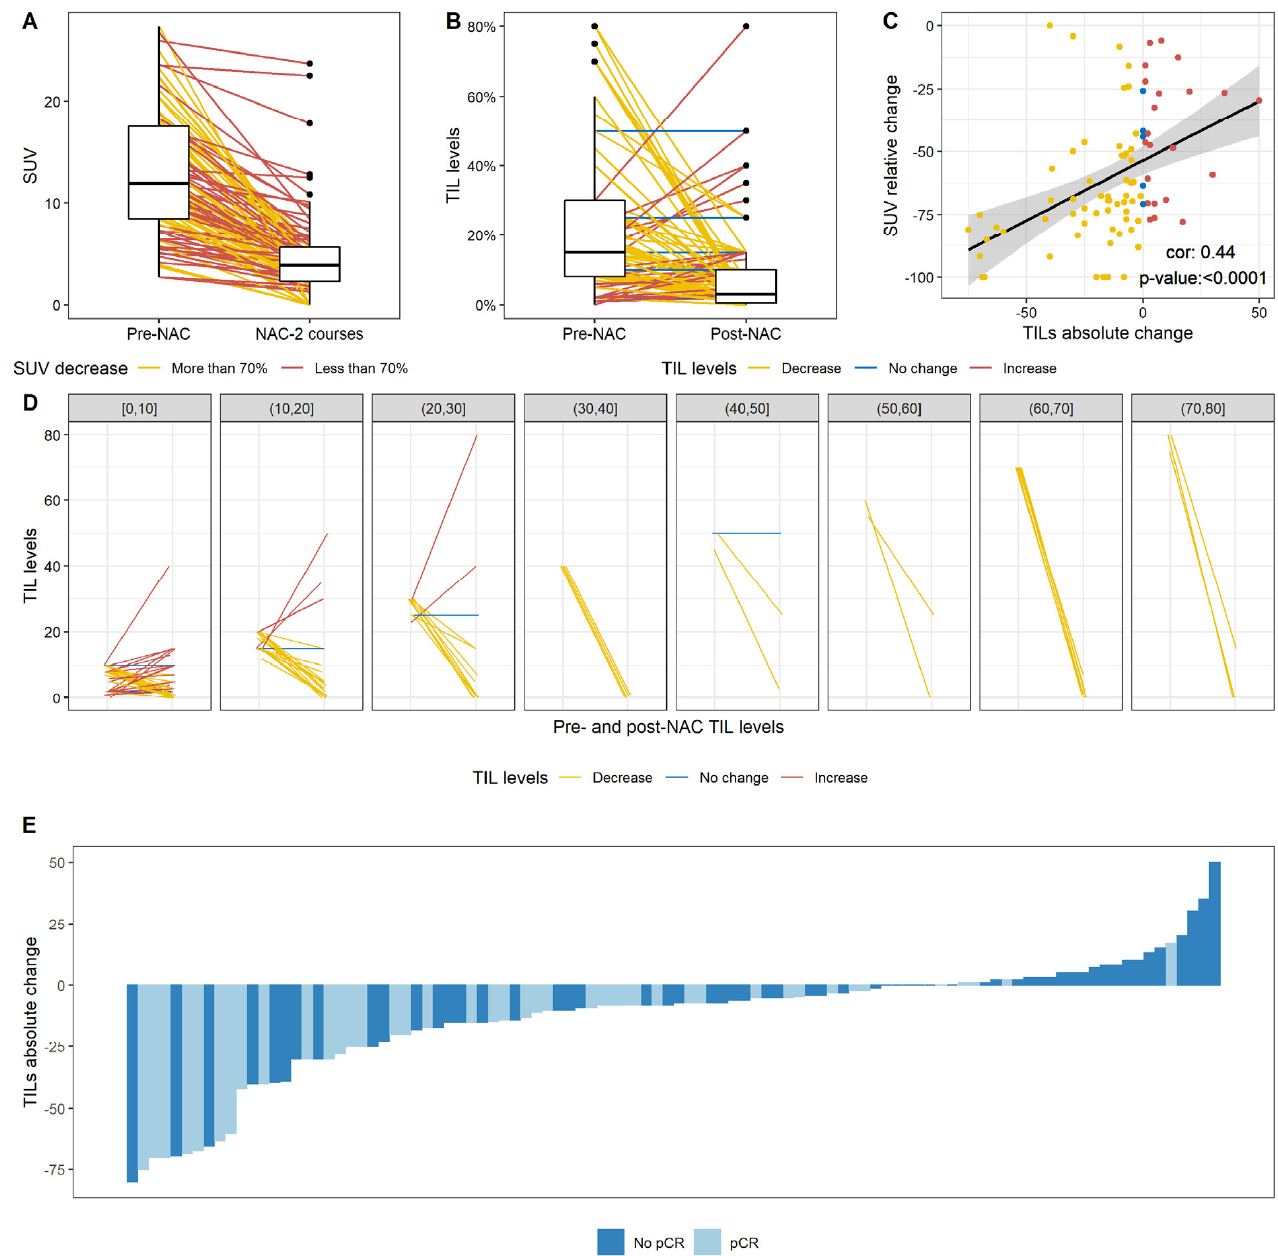
Figure 3. Change after NAC in SUV levels, TIL levels, and the correlation between the relative change in SUV and the absolute change in TIL levels. ( A ) Change in SUV levels after two courses of NAC. The lines indicate the pre NAC and post NAC (after two courses of NAC) paired SUV results for a given patient and are colored according to the category of change in SUV (more than 70%; less than 70%); ( B ) Change in TIL levels after NAC; ( C ) Pearson correlation between the relative change in SUV and the absolute change in TIL levels. Points are colored according to the category of change in TIL levels (decrease; no change; increase in TIL levels); ( D ) Change in TIL levels according to pre-NAC TIL level, binned by increments of 10%. ( B , D ) Lines indicate the paired pre and post NAC paired TIL levels for a given patient and are colored according to the category of change in TIL levels (decrease; no change; increase in TIL levels); ( E ) Waterfall plot representing the change in TIL levels according to pCR status; each bar represents one patient, and patients are ranked in ascending order of change in TIL levels.